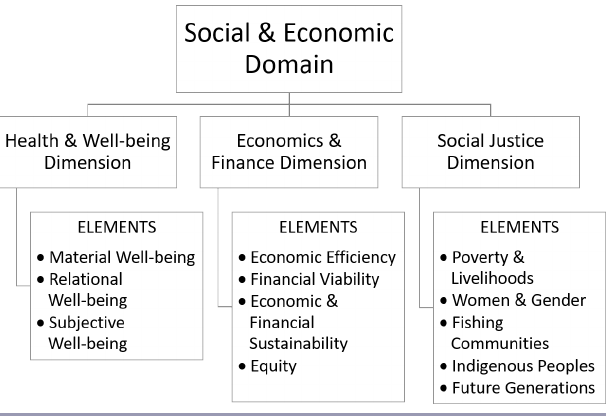
Fig. 3 . Social and economic